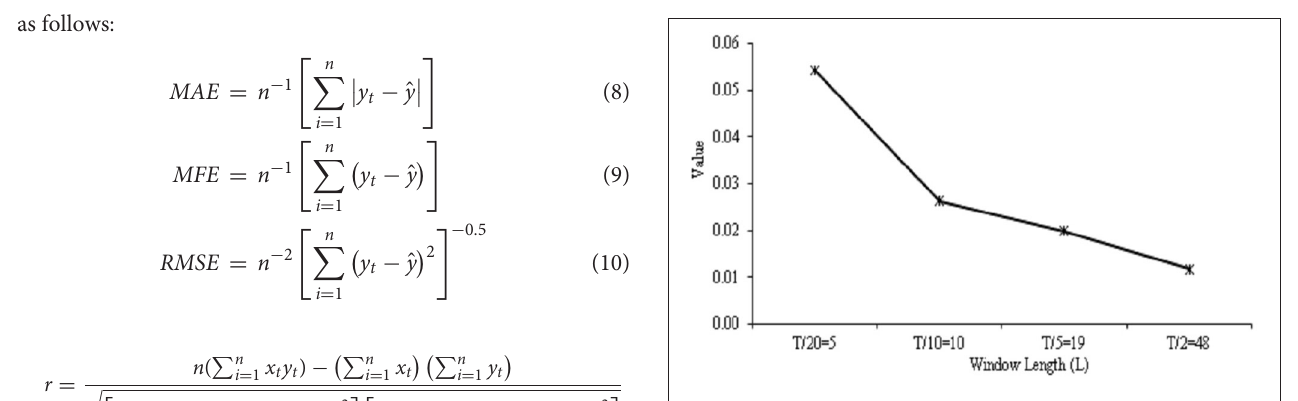
FIGURE 4 | Effect of w -correlation based on SSA using COVID-19 data at varied window lengths.